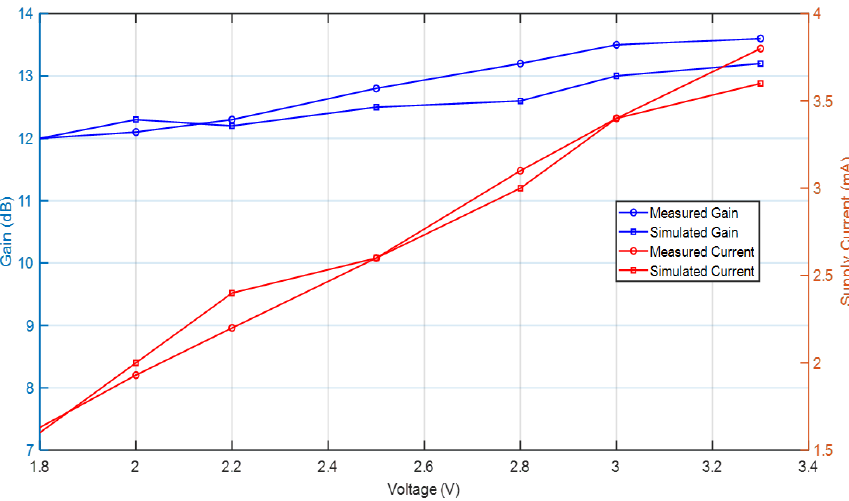
Figure 17. Behaviour of simulated and measured gain and supply current under tuned supply voltage 1.8–3.3